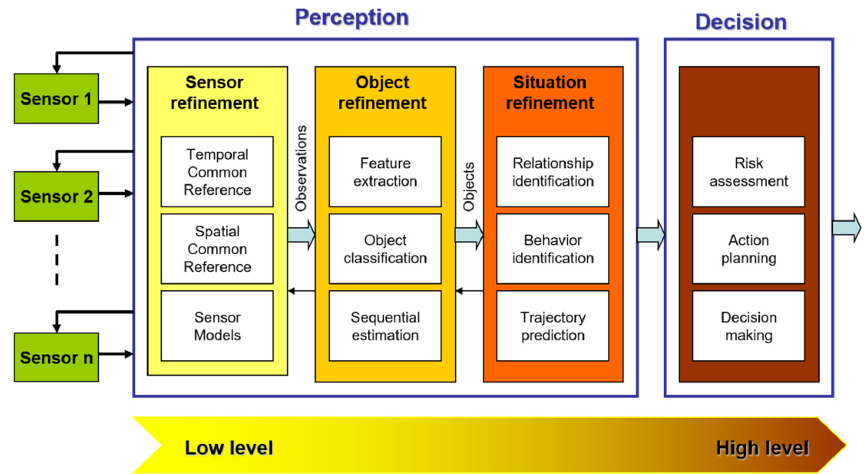
Figure 3. The di ff erent stages in the perception and the decision process.